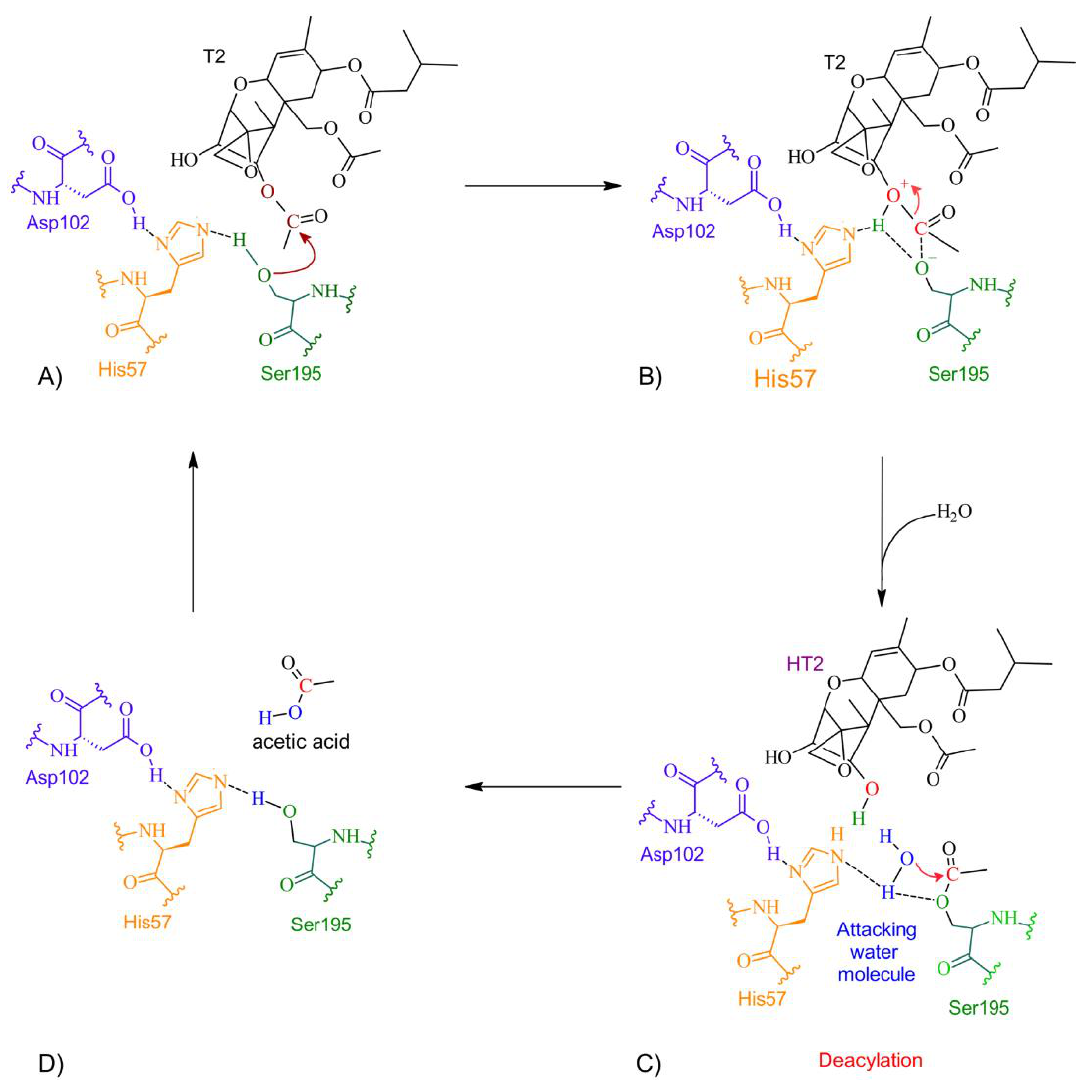
Figure 10. The detoxifying mechanism in T-2 by trypsin. ( A ) Ser195 attacks the carbonyl of the ester group in T-2, and an intermediate is formed. ( B ) The electron pair from the ester bond is transferred to the oxygen to break the ester bond. A proton is transferred from His57 to the hydroxide at the former molecule and HT-2 is released. ( C ) A water molecule enters and interacts with His57 and Ser195 to form an intermediate and the diacylation process initiates. The oxygen coming from the water molecule attacks the carbonyl with the Ser195. ( D ) A molecule of acetic acid is released, and the active site is restored.